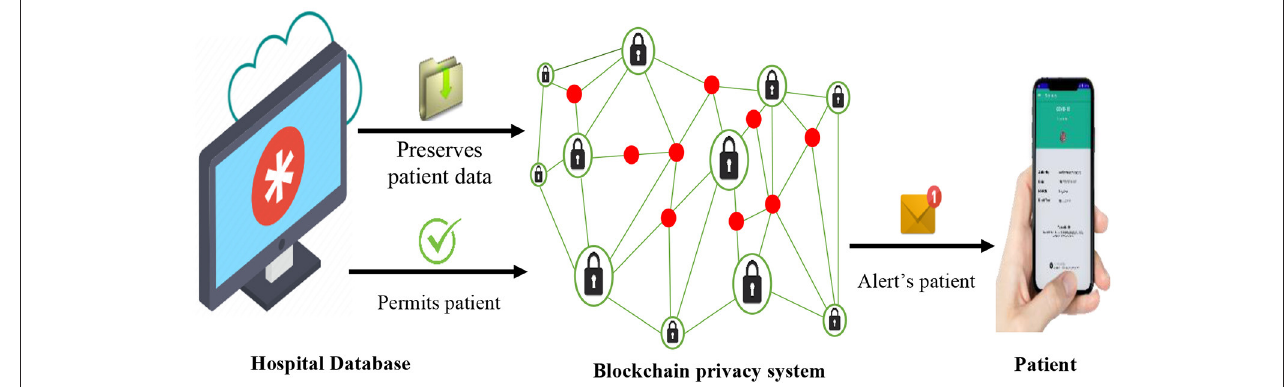
FIGURE 1 | BPS-based data storage and patient alert preservation system.